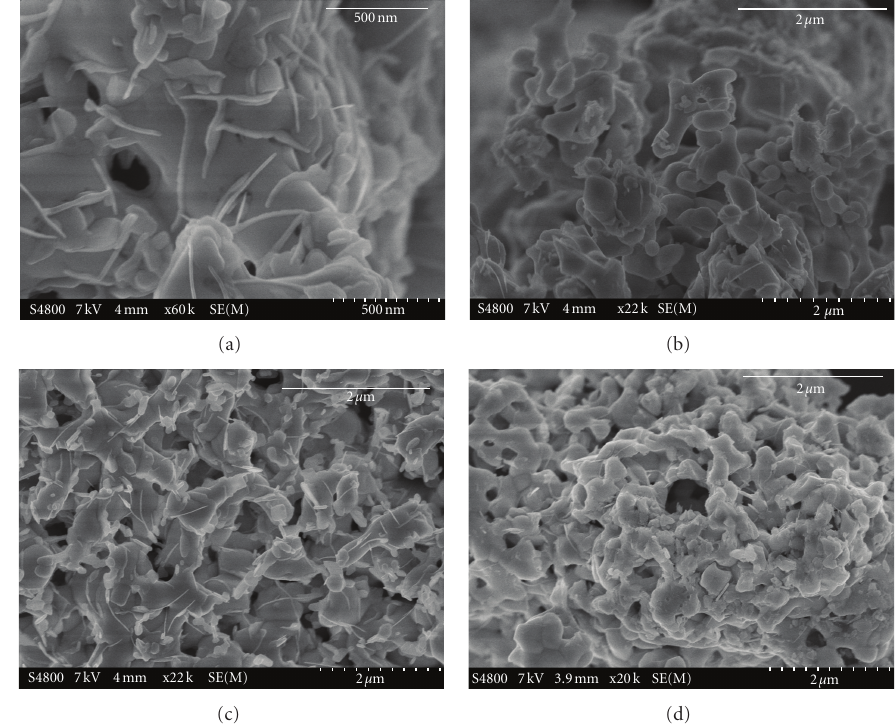
Figure 2: Morphologies of annealed undoped and nitrogen-doped Bi 12 TiO 20 micro- and nano crystals observed by SEM: (a) Bi 12 TiO 20 ; (b) Bi 12 TiO 20 − x N x ( x = 0 . 01); (c) Bi 12 TiO 20 − y N y ( y = 0 . 03); (d) Bi 12 TiO 20 − z N z ( z = 0 .